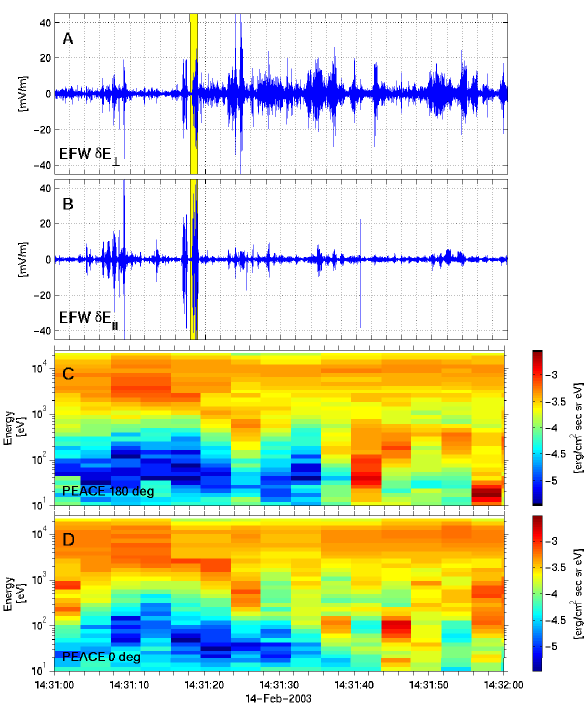
Fig. 5. A detail of the event in Fig. 1. Another example of waves with larger parallel (panel B ) than perpendicular (A) component of the electric field which shows good correlation with electron dis- tributions without cold electrons ( C and D ). The yellow sequence (panels A and B) will be studied further in detail in Fig. 6 and in the theory section in Figs. 10–12. Fig. 6. PEACE instrument data showing phase space density for